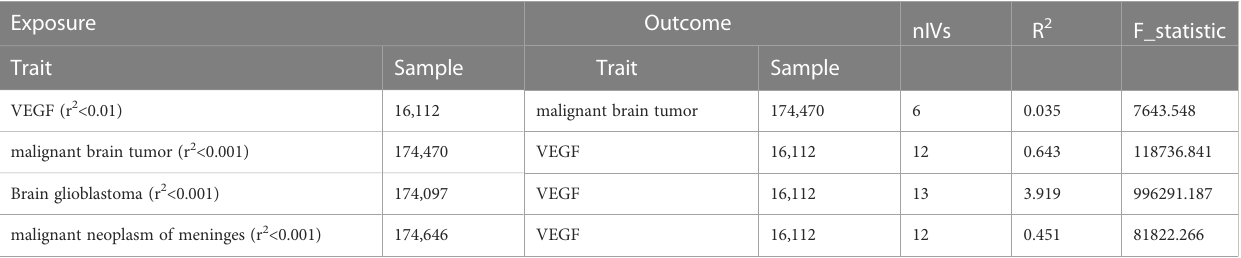
malignant neoplasm of meninges (r 2 <0.001) VEGF, vascular endothelial growth factor; MR, Mendelian randomization; R 2 , variance for SNPs; nIVs, number of instrumental